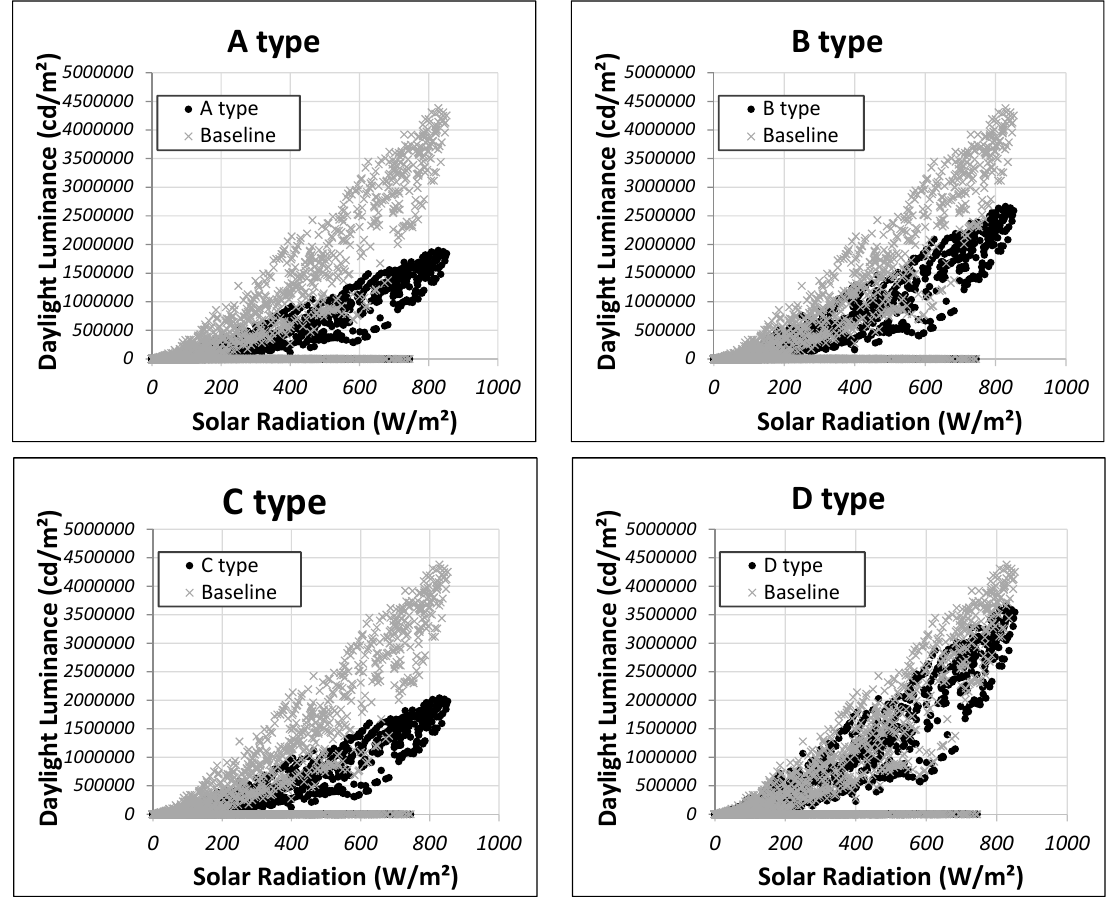
Figure 9. Analysis result of annual daylight luminance analysis by PDLC film type.